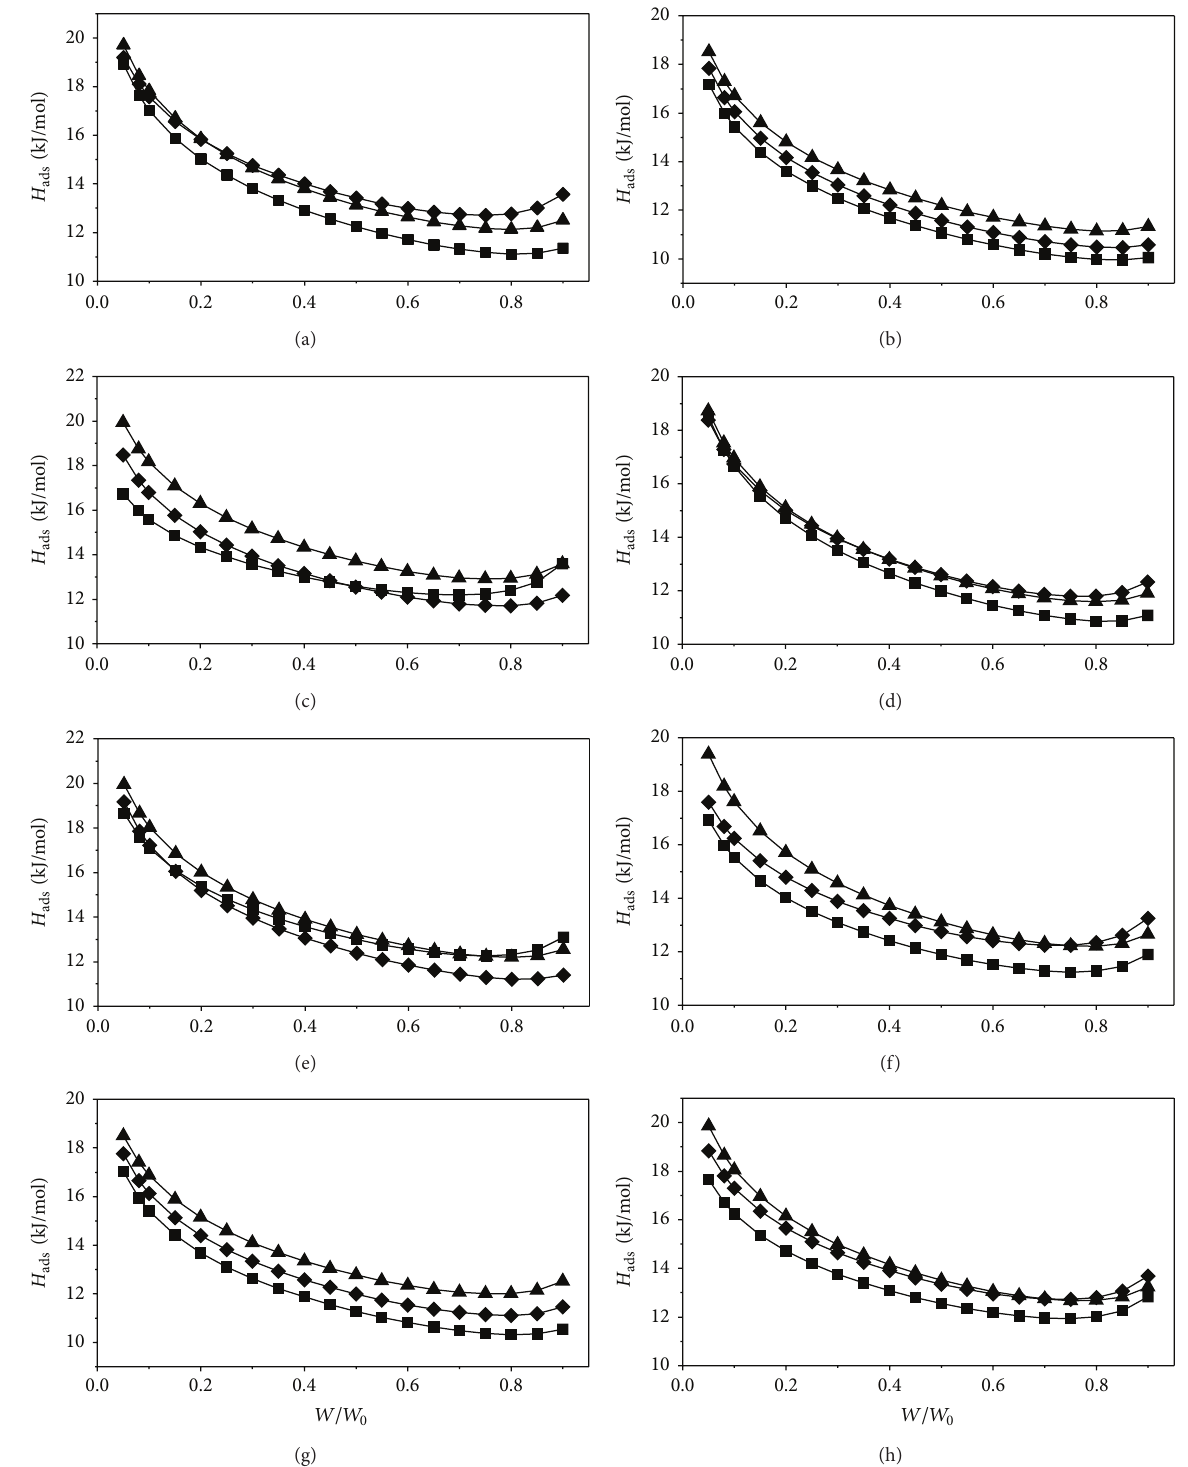
Figure 7: Heat of adsorption ( 𝐻 ) for methane/coal systems against surface loading ( 𝑊/𝑊 0 ) at various temperatures. ◼ , 298.15 K; ⧫ , 313.15 K; ads and 󳵳 , 328.15 K. (a) A1, (b) A2, (c) A3, (d) A4, (e) A5, (f) A6, (g) A7, and (h)